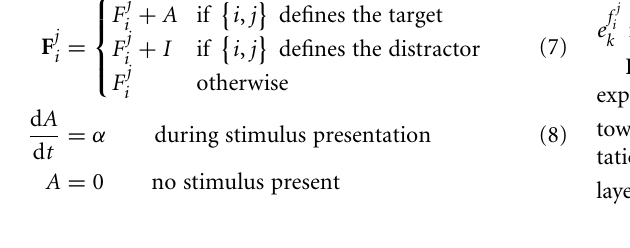
FIGURE 5 | Distribution of membrane potentials averaged over 10,000 trials. Note that the potentials are mostly uniformly distributed, as the color map only covers values from 0.0098 to 0.0115. Nevertheless, the fine grained plot reveals the processes generating the firing rates analyzed in Figure 4 : initially all neurons are pushed toward higher membrane potential by the